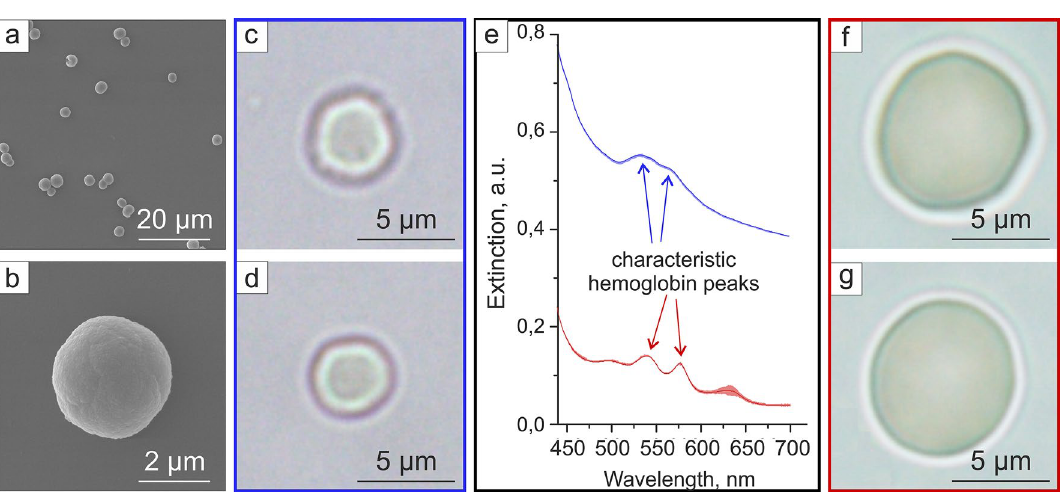
Figure 3. RBCs and their phantoms. ( a , b ) SEM images of RBC phantoms of different scales; ( c , d ) typical optical images of two RBC phantoms; ( e ) absorption spectrum of RBC (red) and RBC phantoms (blue), lighter background represents standard deviation; ( f , g ) typical optical images of two natural (Fig. 5i) and simulate the non-homogeneous melanin content (Fig. 5d,e). Moreover, we found that the amount of melanin in cells increased along with cell growth under the proposed conditions (see “Methods”). To illus- trate melanin content dependence on cultivation time, absorption of cell suspension in Dulbecco’s phosphate- buffered saline (DPBS) (10 7 cells per mL) was measured after 3 and 7 days of cultivation (Fig. 5h). The absorption